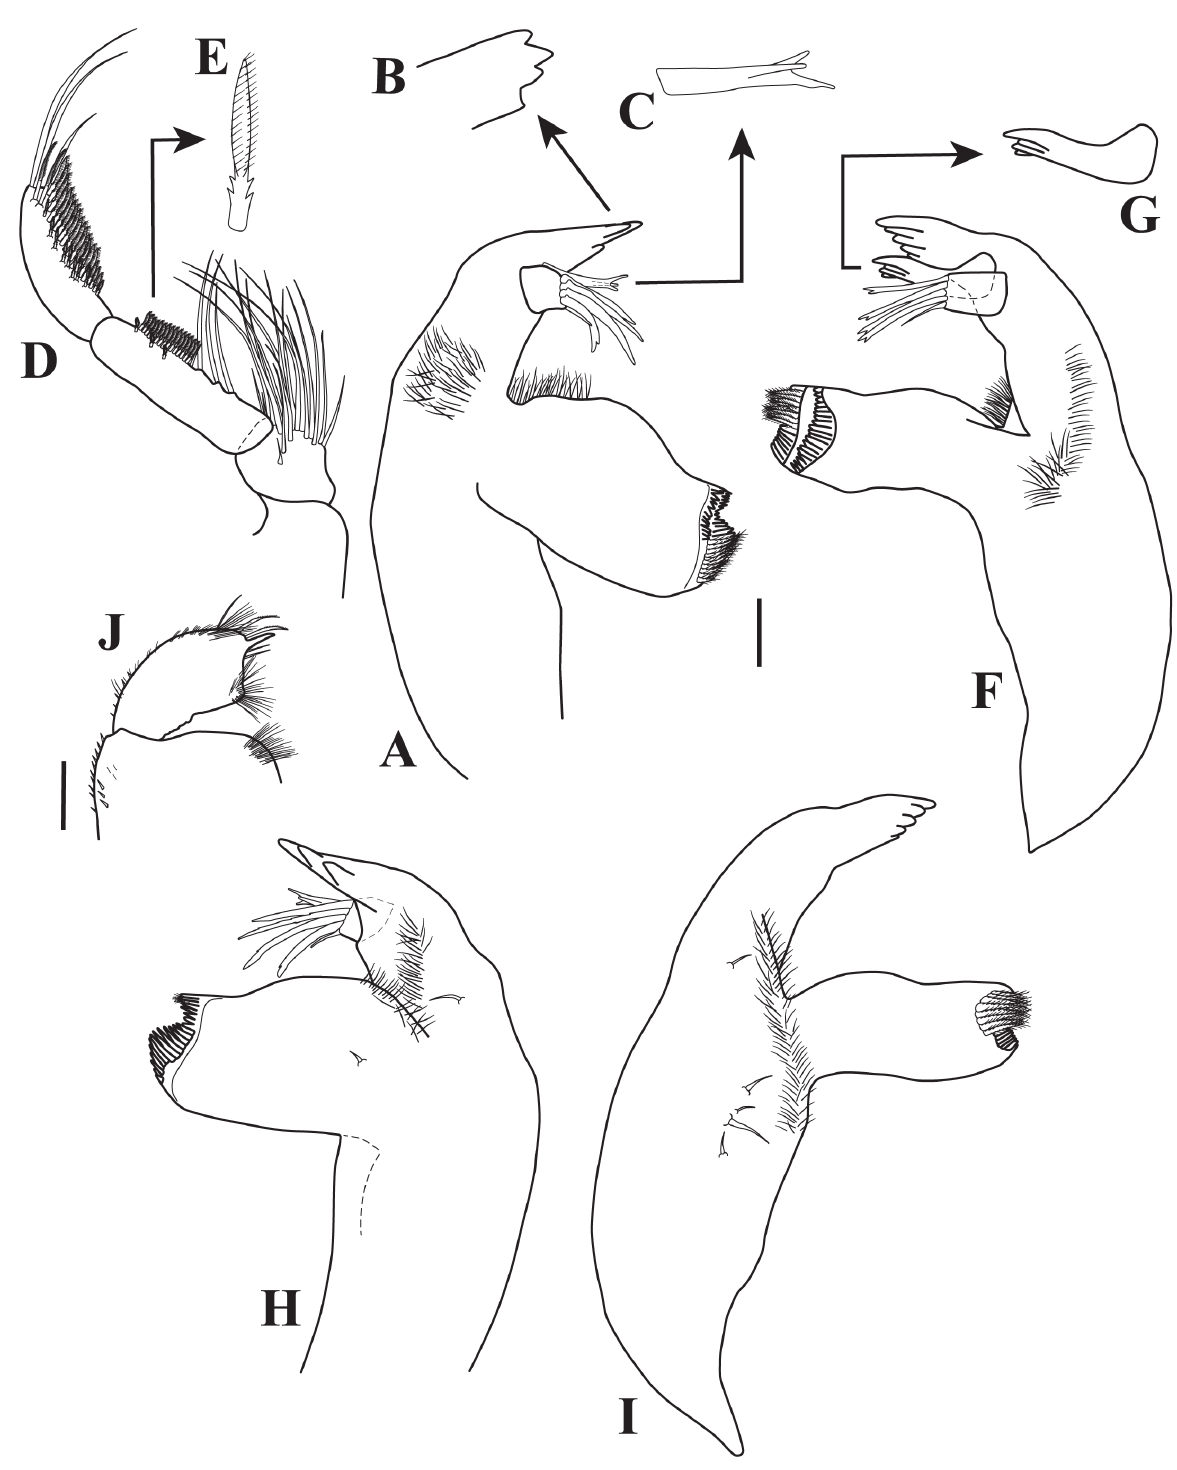
Figure 4. Brachylicoa lui sp. n. holotype female with oostegites and genital cone. A and H right mandible; B enlargement of tip of right incisor process; C enlargement of right lacinia mobilis ; D right mandible palp; E enlargement of pectinate seta; F and I left mandible; G enlargement of left lacinia mobilis ; J labium. Scale bars = 0.1 mm for A , D − E , G − I .